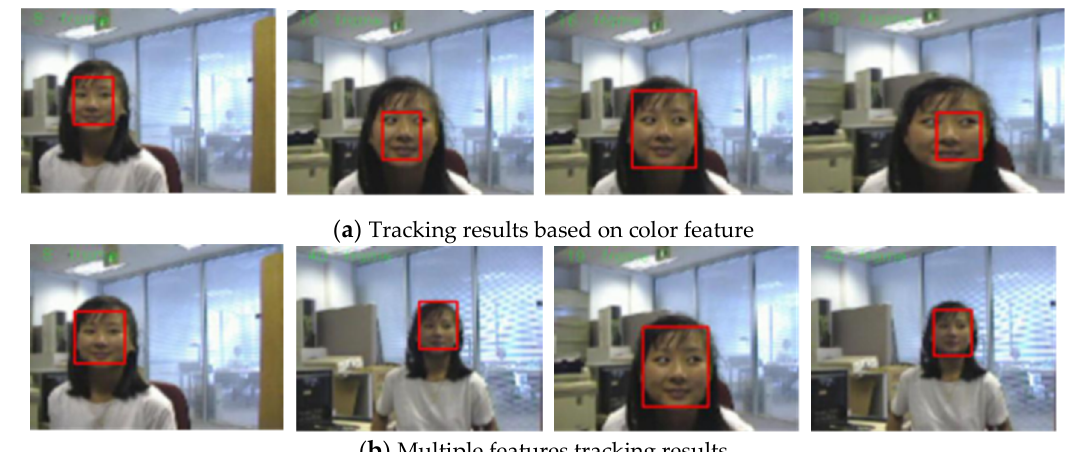
Figure 8. Tracking results under the background changes.